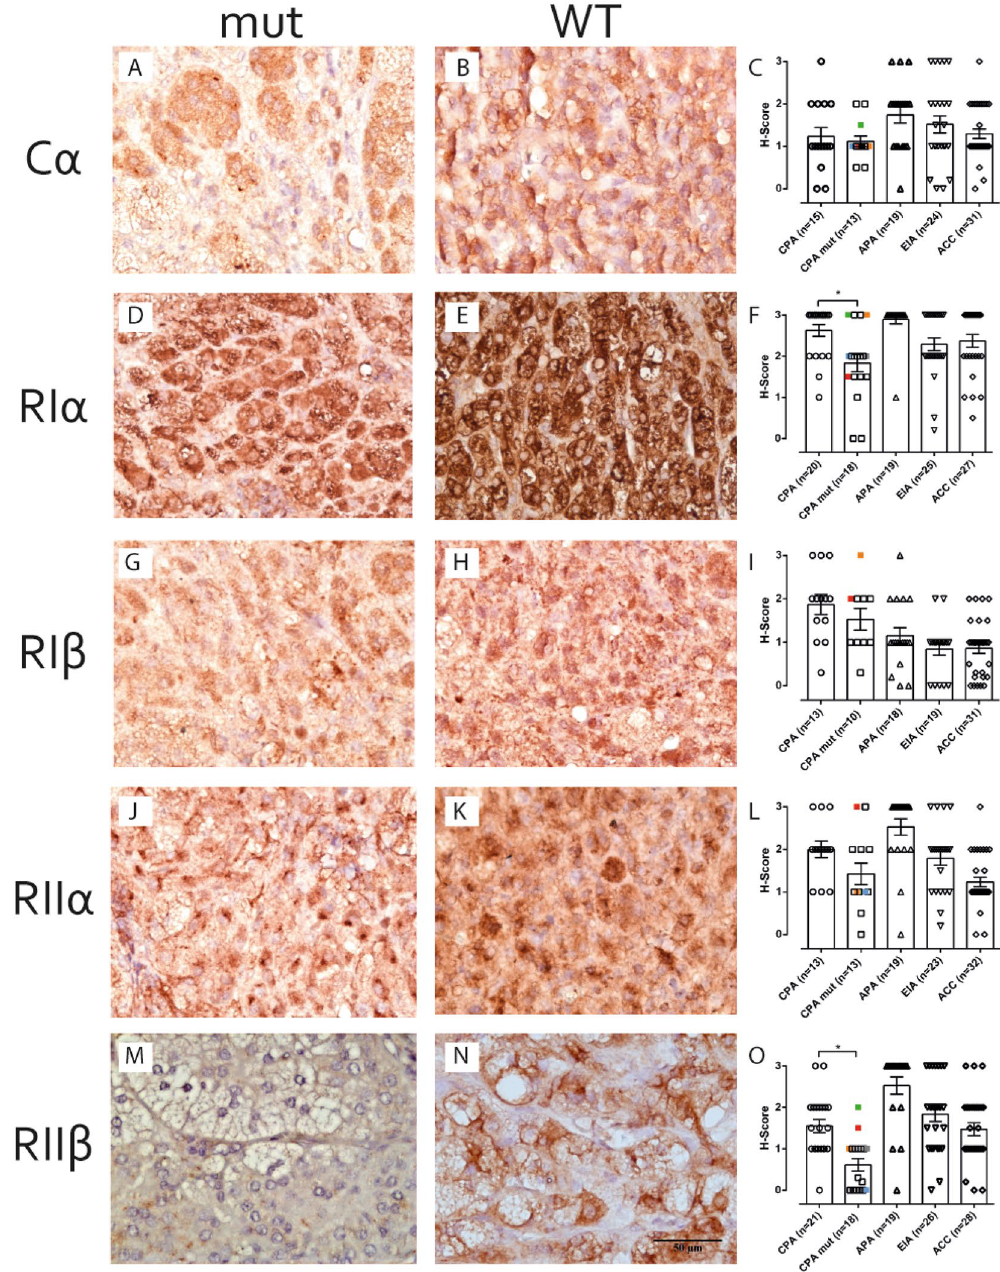
Figure 1. Immunhistochemical staining of the PKA subunits on CPA. Representative immunohistochemical staining for the PKA C α subunit in CPA PRKACAmut ( A ) and CPA PRKACAWT ( B ). An analysis of all stained tissues for C α is shown in ( C ). Representative immunohistochemical staining for the PKA RI α subunit in CPA mut ( D ) and CPA WT ( E ). An analysis of all stained tissues for RI α is shown in ( F ). Representative immunohistochemical staining for the PKA RI β subunit in CPA mut ( G ) and CPA WT ( H ). An analysis of all stained tissues for RI β is shown in ( I ). Representative immunohistochemical staining for the PKA RII α subunit in CPA mut ( J ) and CPA WT ( K ). An analysis of all stained tissues for RII α is shown in ( L ). Representative immunohistochemical staining for the PKA RII β subunit in CPA mu ( M ) and CPA WT ( N ). An analysis of all stained tissues for RII β is shown in ( O ). Mutations, other than the L206R mutation are indicated in different colours. p.200_201insV: blue, p.199_200insW: grey, p.E32V: green, pW197R: orange, p.245_248.del: red. Kruskal-Wallis test with Dunn’s correction for multiple comparisons was performed to determine statistically significant differences between all data sets. * p <